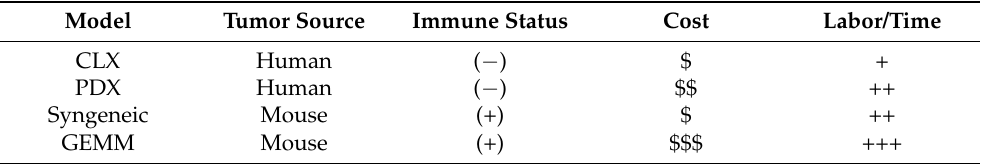
Table 1. Comparison of preclinical animal model features. Model Tumor Source Immune Status Cost Labor/Time CLX Human PDX Human Syngeneic Mouse